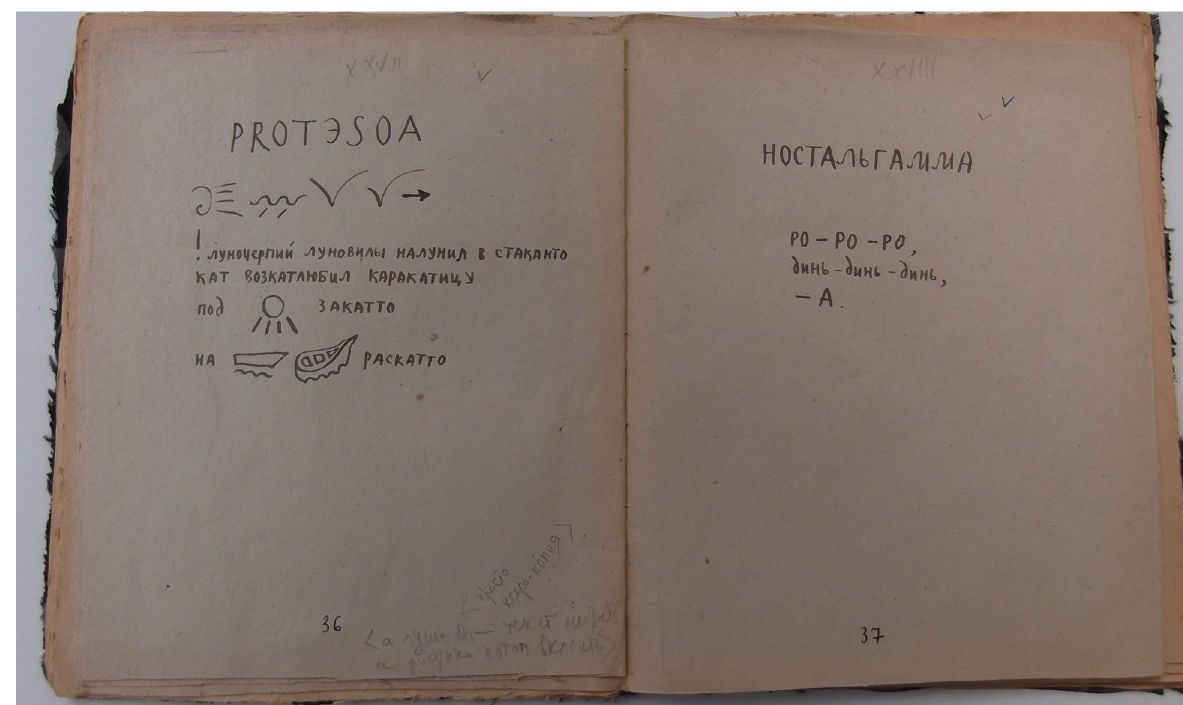
Figure 6. ‘Shedevrez’, p. 36–37.